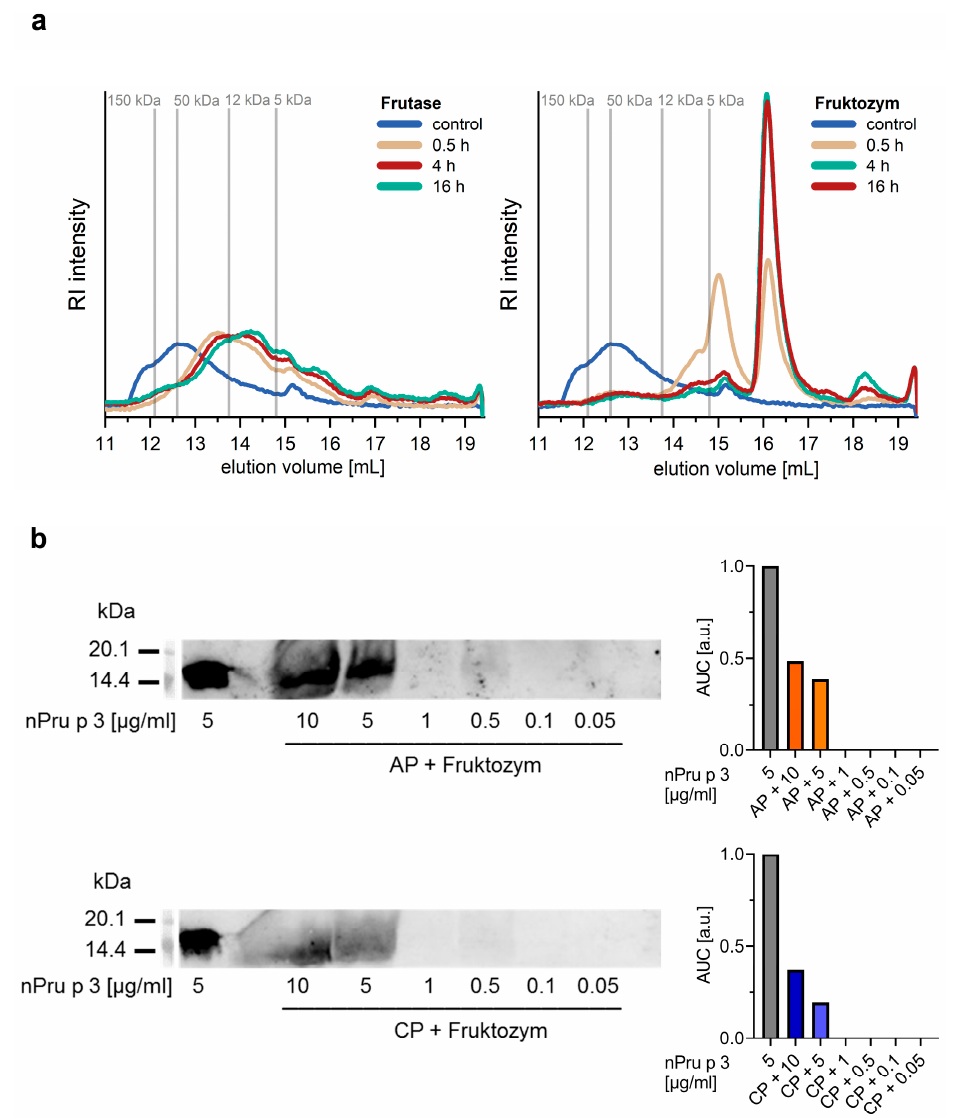
Figure 4. Size exclusion chromatography (SEC) coupled with refractive index (RI) detection derived chromatograms of AP treated with Frutase ® ( left ) and Fruktozym ® ( right ) over different incubation times and an untreated control. Dextrans with different molecular weights were used as markers (vertical lines) ( a ). Detectability of nPru p 3 in Fruktozym ® -treated 10% apple-derived pectin (AP) and 10% citrus-derived pectin (CP) was analyzed via immunoblotting using a cross-reactive nsLTP rabbit antiserum. nPru p 3 (5 µ g/mL) without pectin was used as control. The protein detectability was semi-quantified using the area under the curve (AUC) normalized to blank ( b